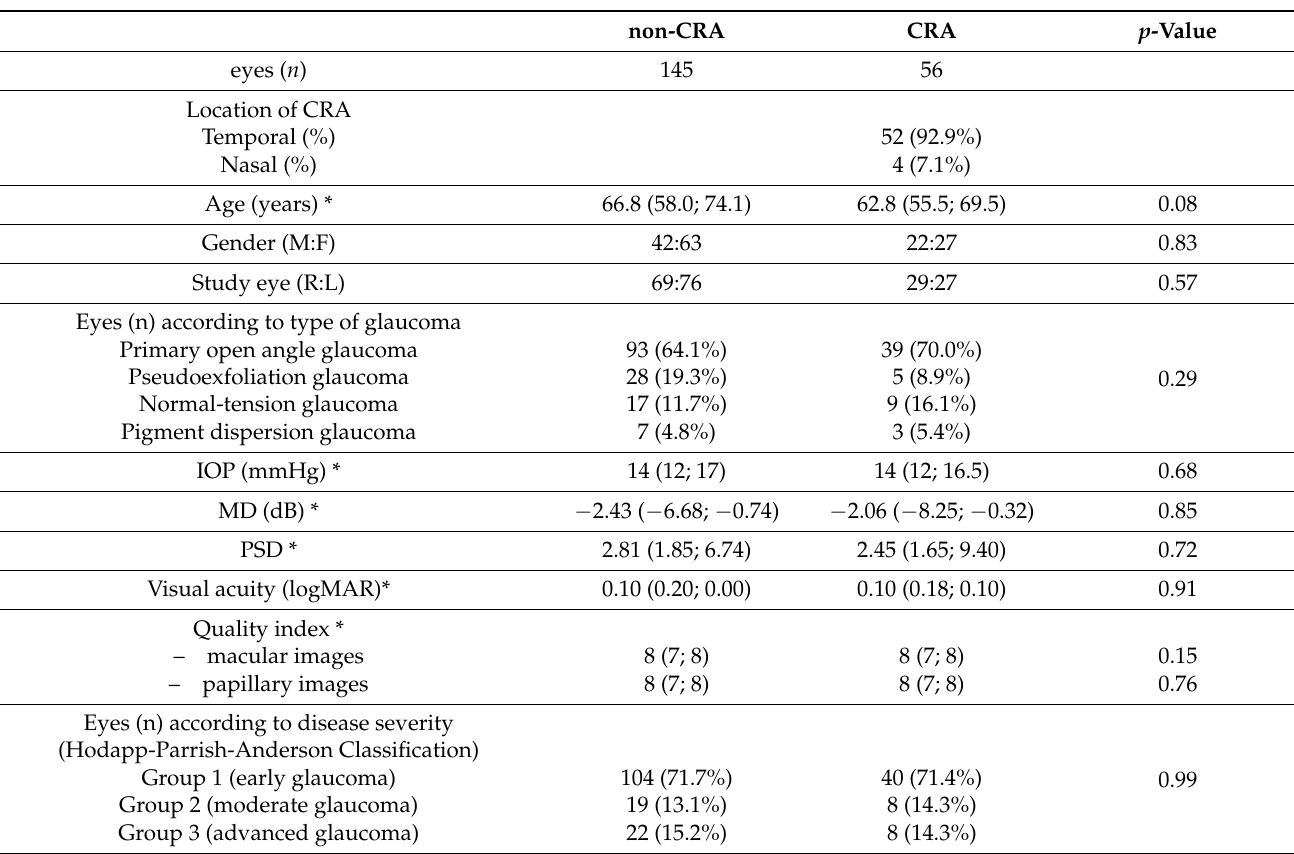
Table 2. Patient characteristics according to the CRA group. Data on the continuous variables are reported as the mean ( ± standard deviation) or the median (25th percentile; 75th percentile), depending on the data